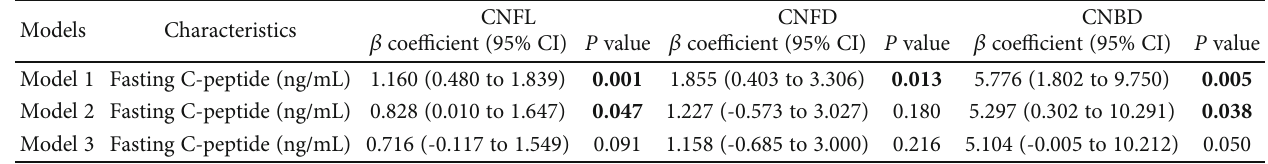
Table 3: Multiple linear regression analysis of C-peptide with corneal nerve parameters (as dependent variable). Models